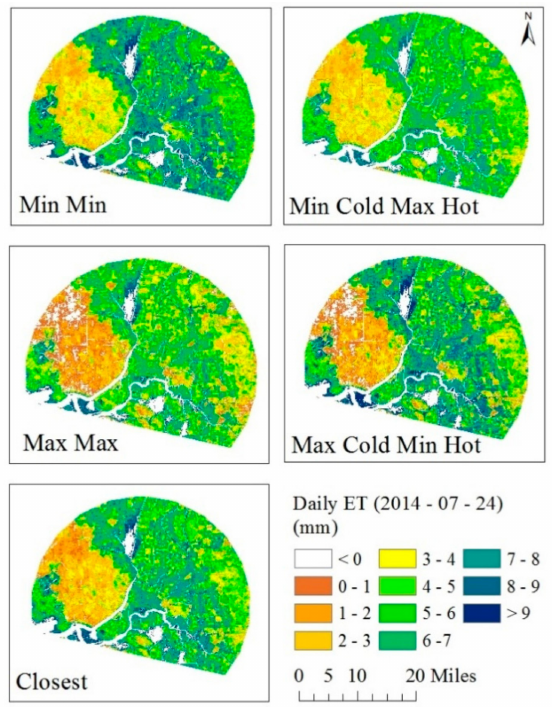
Figure 7. Spatial variation in daily ET based on various calibration sets.